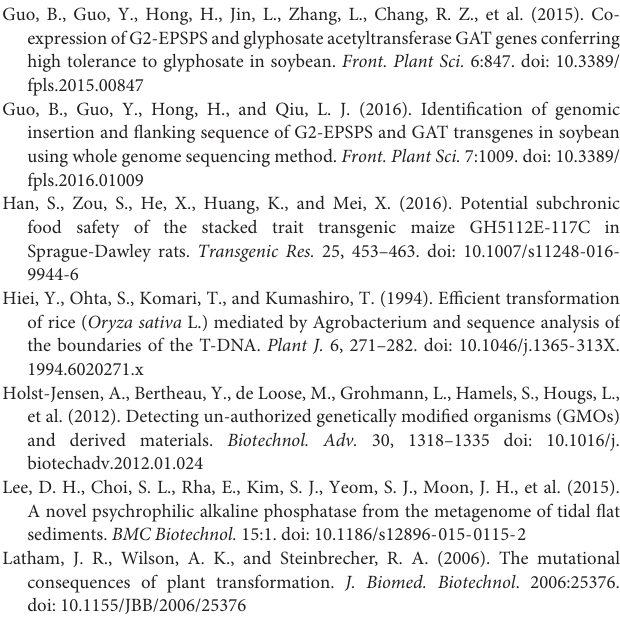
FIGURE S1 | G2-EPSPS gene expression level in T3 transgenic lines. FIGURE S2 | Integration-event-specific PCR of G2-6 transgenic